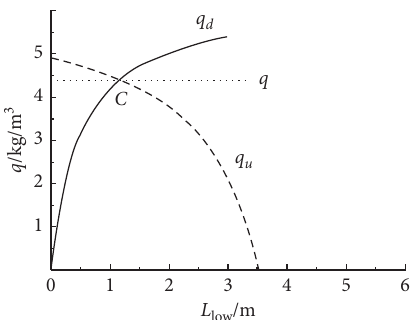
Figure 5: Curves of q − L